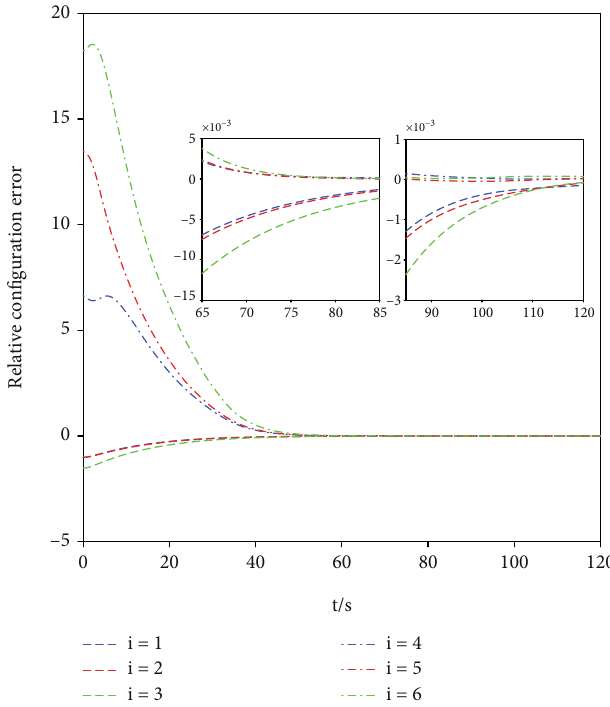
Figure 14: Relative con fi guration error